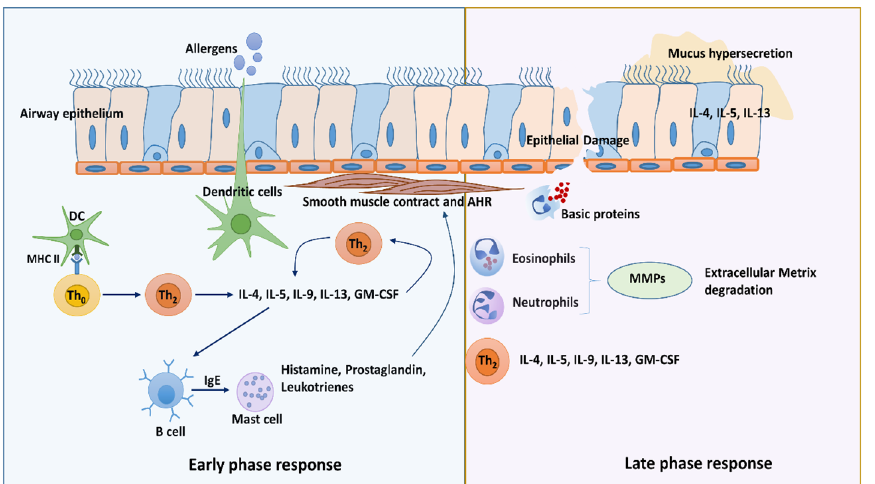
Figure 1. Immune reactions to allergens in asthma. At early response to allergens, dendritic cells (DCs) uptake, process, and present allergen antigens to naïve T cells (Th0). This results in the differentiation of Th0 cells to Th2 cells and secrete Th2 cytokines. These cytokines switch B cells to produce IgE and IgE recruits and activate mast cells. Activated mast cells release mediators that result in smooth muscle contraction and AHR. In the late phase, Th2 cytokines recruit a large number of inflammatory cells, such as eosinophils, neutrophils, and T cells. These inflammatory cells release mediators that cause epithelial damage, mucus hypersecretion, and degradation of extracellular matrix (ECM) and recruit more inflammatory cells into the site.